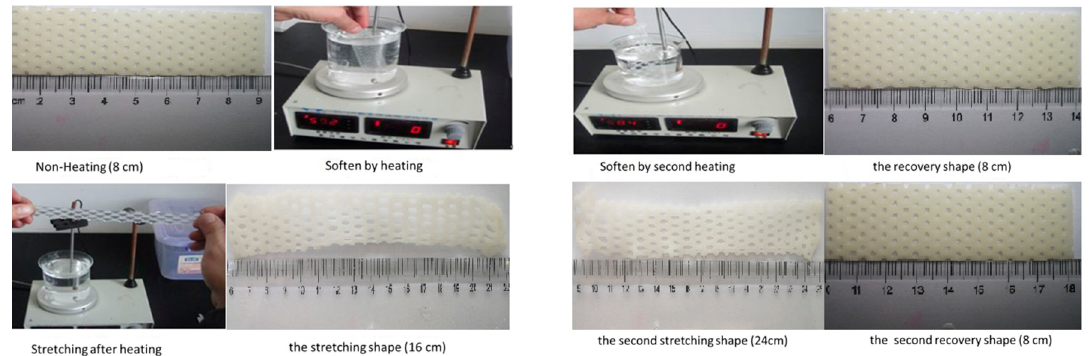
Figure 14. Shape memory process analyses of thermoplastic plates.